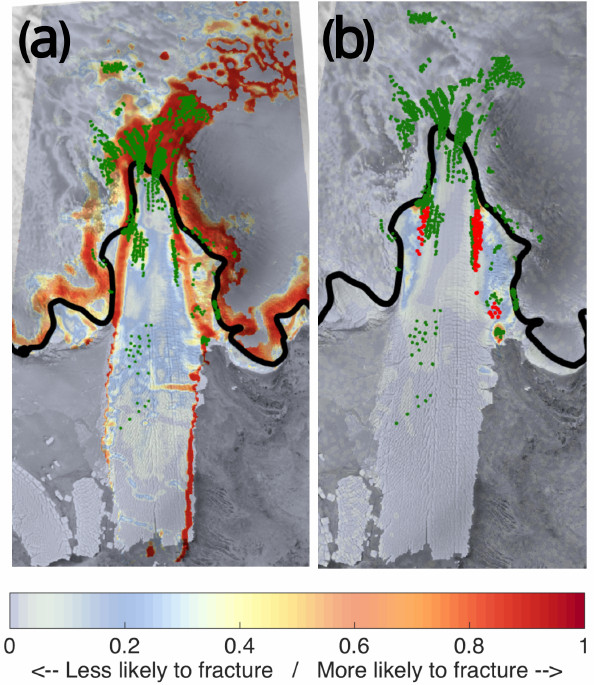
Figure 8. Modelled probability (a) and damage (b) at Mertz IS (group 1). Labels are the same as in Fig.